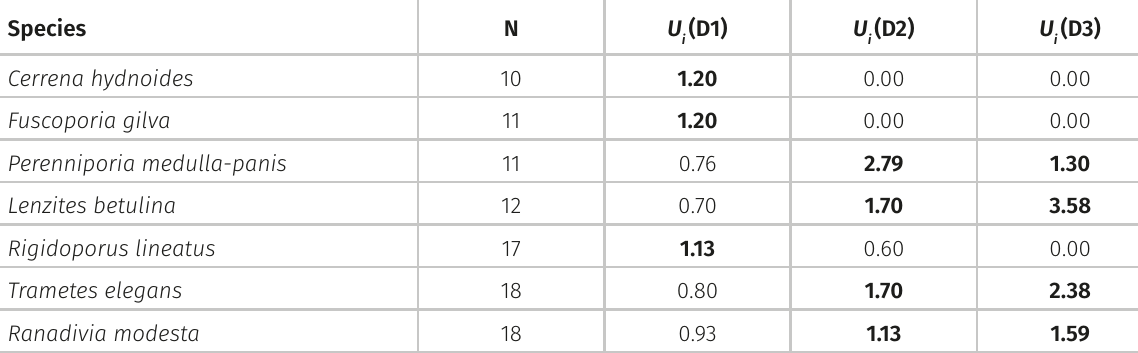
) of Hymenochaetales and Polyporales species in dead trunks near the Silvio Braga Table VI. Usage index ( U i HPP, Santarém, PA, second stage of decomposition of the trunks (D1, D2 and D3). N = abundance. Values in bold significant to